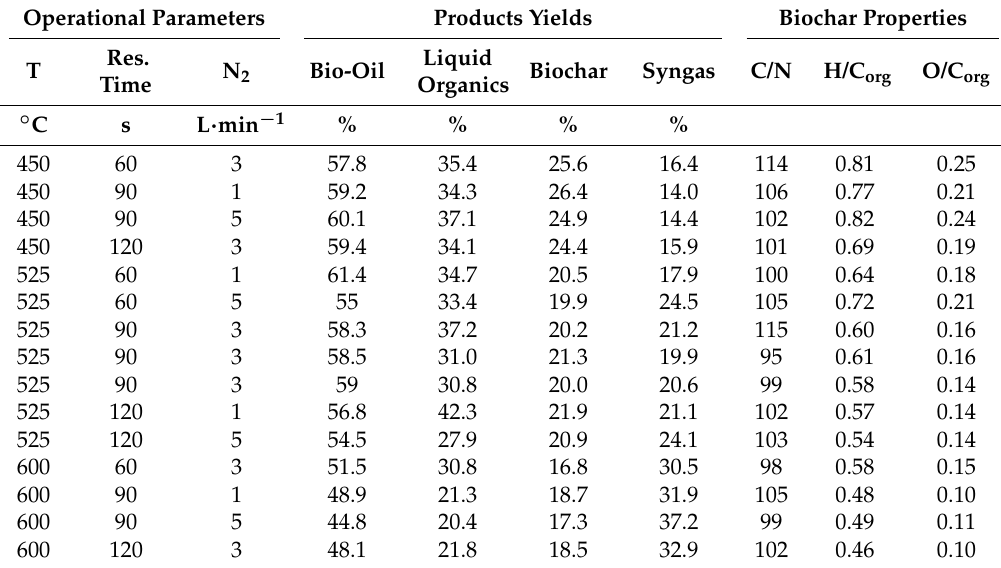
Table A2. Pyrolysis of Switchgrass—Experimental